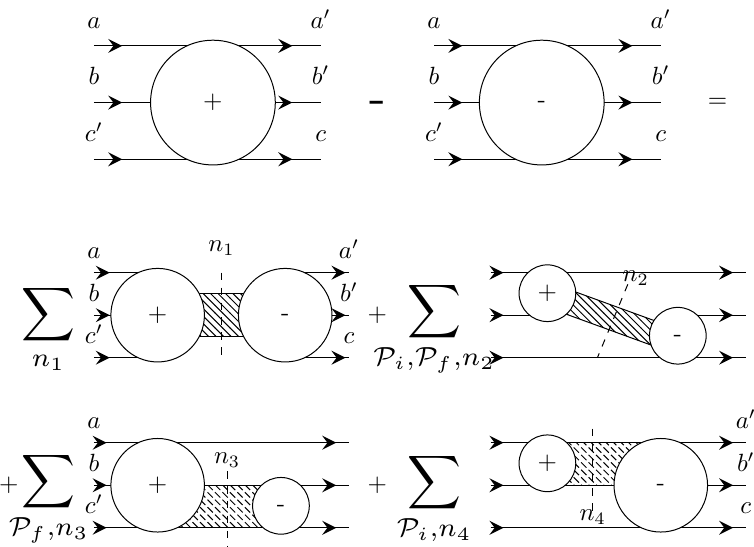
Figure 8. A schematic representation of unitarity equation for connected three-to-three scattering amplitudes from